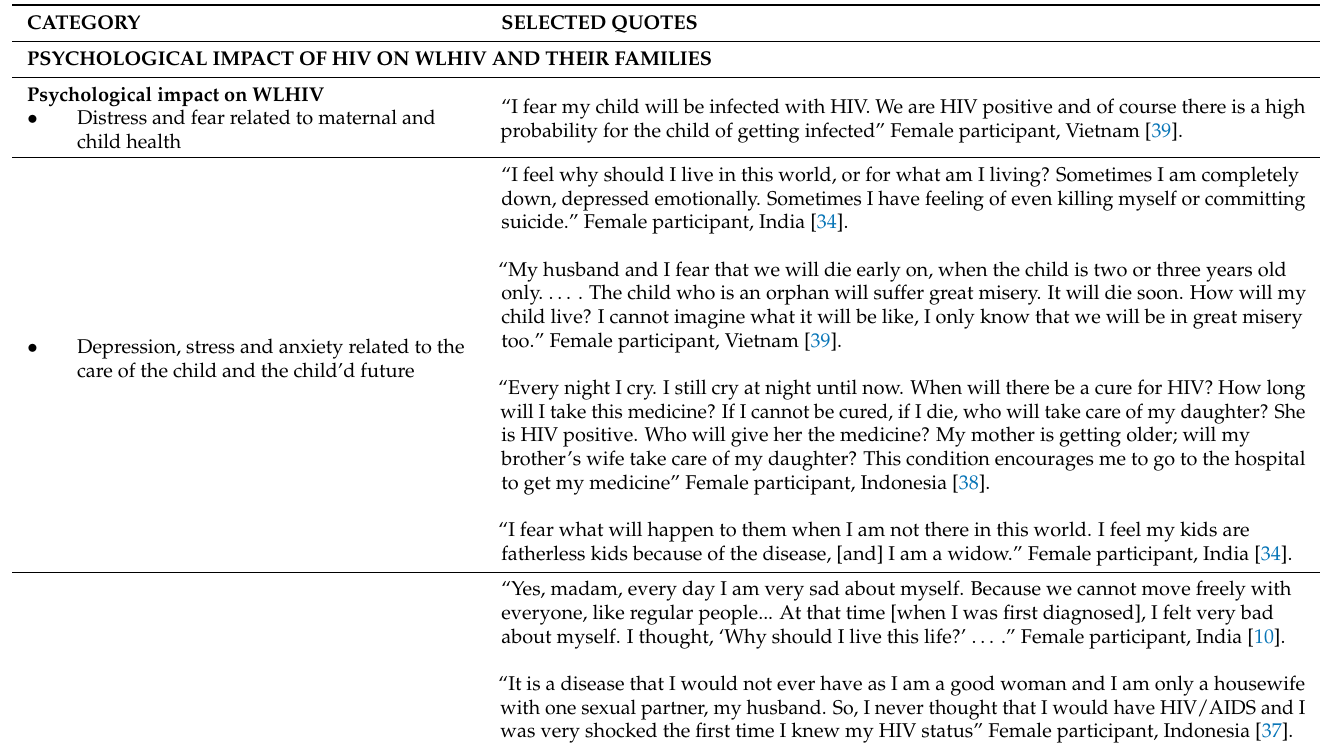
Table 2. Qualitative evidence of the impact of HIV on WLHIV and their